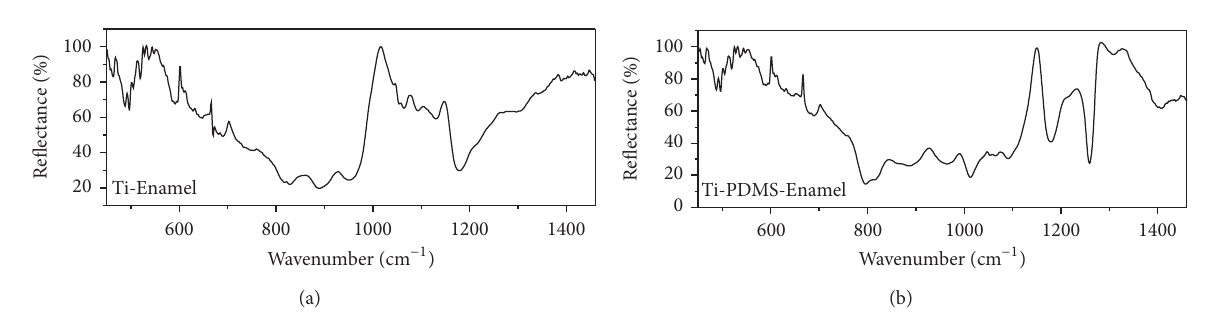
Figure 3: IR spectra of Ti-Enamel (a) and Ti-PDMS-Enamel (b)